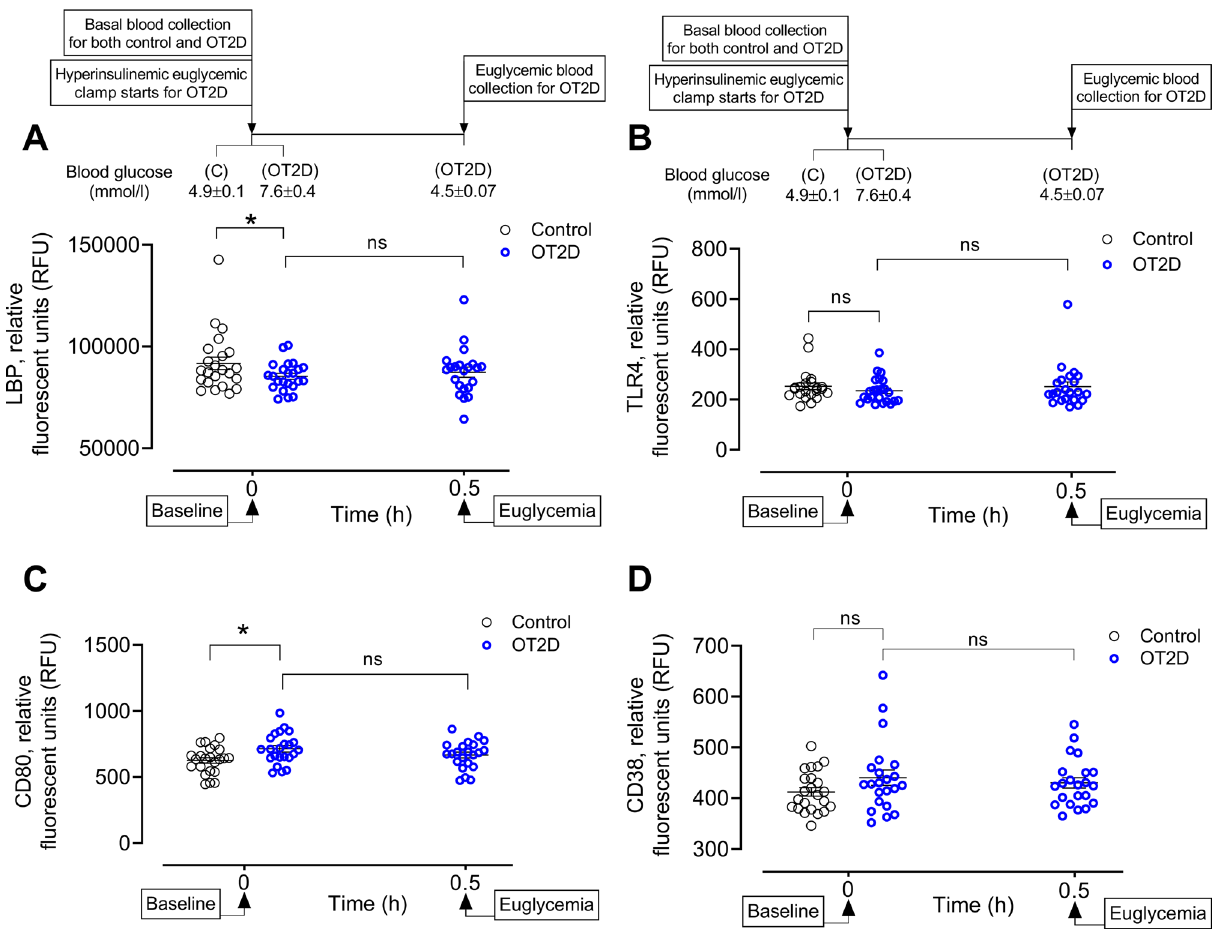
Figure 1. Circulatory levels of M1 macrophage activation markers in the steady state of obese type 2 diabetes (OT2D). Plasma LBP ( A ), TLR4 ( B ), CD80 ( C ) and CD38 ( D ) levels in control subjects (black circles) and obese subjects with T2D (blue circles). Basal level of plasma LBP was higher (85,311 ± 1453 vs 91,747 ± 3048 RFU of LBP, OT2D vs control, p < 0.05) but TLR4 was unchanged in OT2D (235 ± 11 vs 254 ± 13 RFU of TLR4, OT2D vs control, p = ns). Basal levels of plasma M1 macrophage surface markers CD38 and CD80 were also higher in OT2D (714 ± 24 vs 626 ± 21 RFU of CD80, OT2D vs control, p < 0.01; 441 ± 15 vs 408 ± 7 RFU of CD38, OT2D vs control, p < 0.05). Acute normalization of glycemia had no effect on levels of LBP, CD80 or CD38 in T2D subjects (A-D). Data were presented as mean ± SEM. *, p < 0.05, **, p < (M2b) or TGB-β (M2c). Consistent with our hypothesis, we found a significant elevation of basal TGF-β1 level in OT2D (1123 ± 72 vs 933 ± 27 RFU of TGF-β1, OT2D vs control, p < 0.01) (Fig. 3A) [recently reported in 18 ]. Basal level of plasma CD163 (soluble CD163, sCD163) was higher in OT2D compared to control (2748 ± 256 vs 2297 ± 124 RFU of sCD163, OT2D vs control, p < 0.05) (Fig. 3B). We further measured the plasma CD206 (soluble CD206, sCD206), another potent marker for M2 macrophage receptor, and found that there was no change in the basal level of plasma CD206 (10,600 ± 477 vs 9885 ± 431 RFU of sCD206, OT2D vs control, p = ns) (Supplementary Fig. 3A). We next explored other potent M2 macrophage soluble receptor markers to determine if the basal concentra- tion was also increased in the plasma of OT2D compared to control subjects. Our data indicate that there were no changes in plasma arginase and CD200R1 (888.2 ± 45.3 vs 963.1 ± 97.2 RFU of arginase and 1055.6 ± 41.4 vs 1102.8 ± 40.6 RFU of CD200R1, OT2D vs control, p = ns) (Supplementary Fig. 3B and C) in OT2D compared to control. Interestingly, the level of plasma CD200 was downregulated in OT2D (2241 ± 85 vs 2426 ± 67 RFU of CD200, OT2D vs control, p < 0.05) (Supplementary Fig. 3D). Basal levels of dendritic cell specific ICAM-3 grab- bing nonintegrin (DC-SIGN, also known as CD209) and CD36 were significantly lower in OT2D compared to control (1221 ± 63 vs 1440 ± 102 RFU of CD209 and 9752 ± 614 vs 11,360 ± 627 RFU of CD36, OT2D vs control, p < 0.05) (Supplementary Fig. 3E and F). The matrix metalloproteinases (MMPs) MMP7 and MMP9 were found to be elevated in OT2D compared to control (1242 ± 93 vs 1005 ± 42 RFU of MMP7 and 30,193 ± 3746 vs 19,532 ± 1562 RFU of MMP9, OT2D vs control, p < 0.05) (Fig. 3C–D) [recently reported in 18 ]. Correction to normoglycemic had no effect on plasma levels of M2 macrophage activation markers in OT2D (Fig. 3A–D).